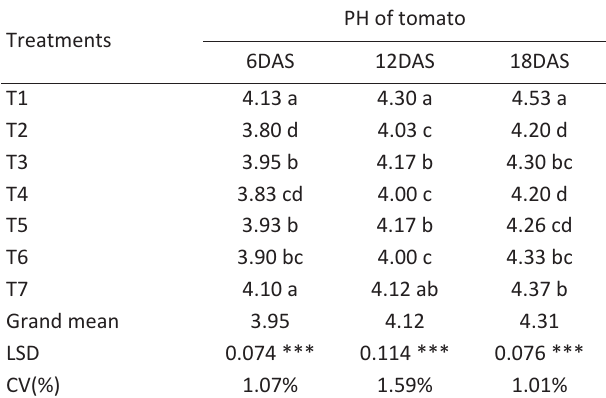
Table 5 ­ Effect of different packaging materials on PH